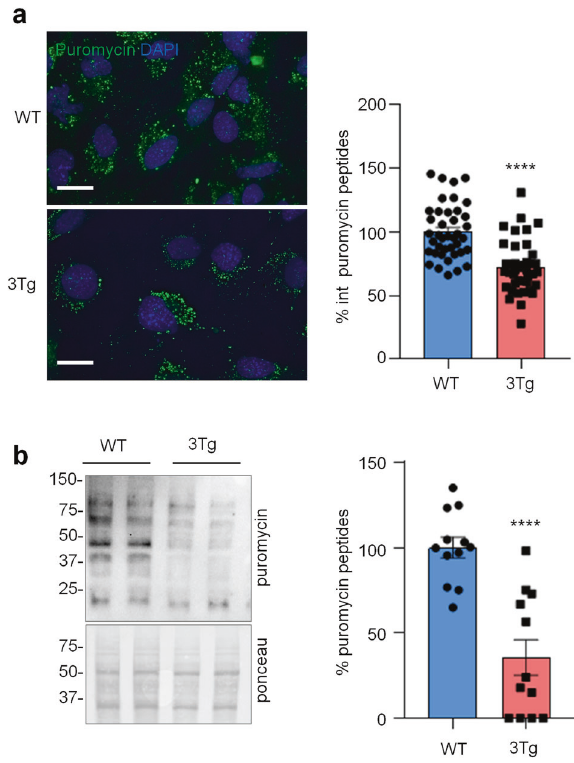
Fig. 1 Protein synthesis analysis in WT- and 3Tg-iAstro cells. a Cells were pulsed with puromycin (4 µM, 1.5 h), fi xed and analysed by IF with anti-puromycin antibody (green) and with DAPI to stain nuclei (blue). Images were acquired with Leica Thunder imager 3D live cell microscope, scale bar = 25 µm. Data are expressed as mean ± SEM, WT-iAstro cells n = 40, 3Tg-iAstro cells n = 40, from 4 independent experiments; **** p < 0.05 by unpaired t -test. b WB with anti-puromycin antibody and ponceau staining on cells treated with 4 µM puromycin. Data are expressed as mean ± SEM of 12 independent experiments; **** p < 0.0001 by unpaired t